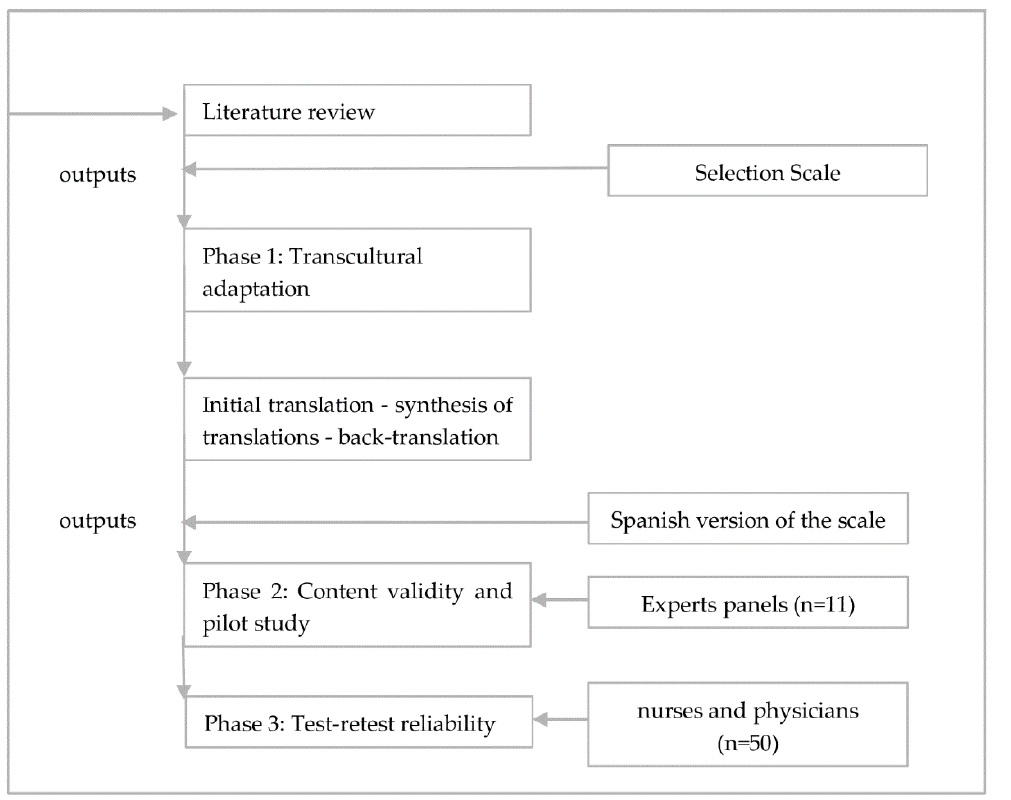
Figure 1. Phases of the study.